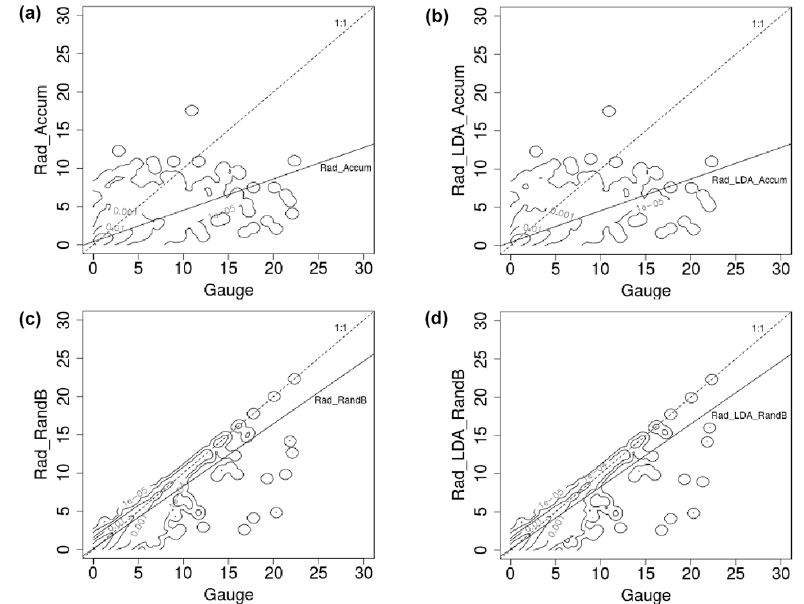
Figure 4. The FMI-LAPS precipitation accumulation (described in plots with density isolines of hourly accumulation values in millime- ters) calculated using four different methods. Fit in solid line (see regression equations), the perfect solution would align on the 1 : 1 dashed line: (a) Rad_Accum ( y = 0 . 410 x + 0 . 398), (b) Rad_LDA_Accum ( y = 0 . 413 x + 0 . 396), (c) Rad_RandB ( y = 0 . 817 x + 0 . 093) and